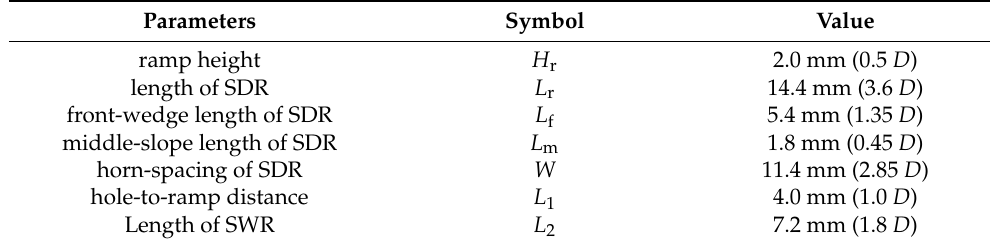
Figure 2. Schematic diagram of upstream ramps: ( a ) detailed parameters of SDR; ( b ) detailed pa- rameters of SWR.